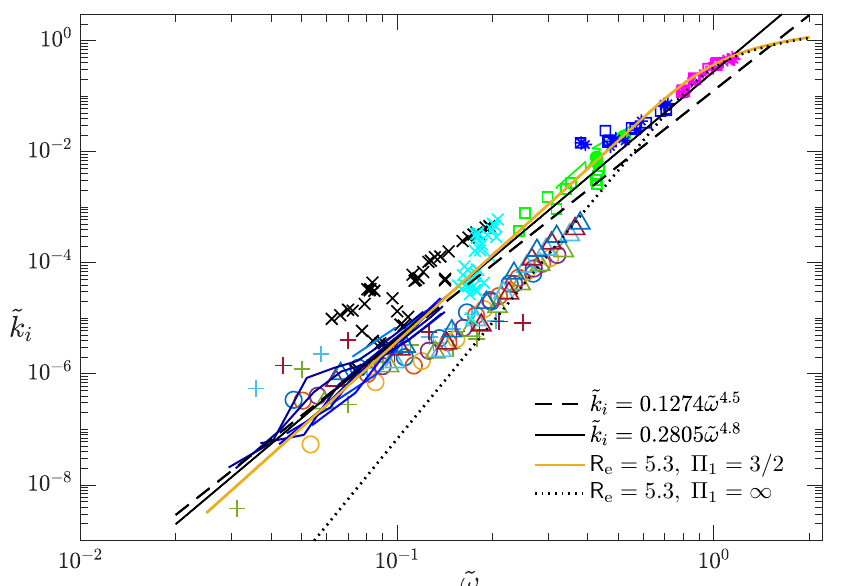
Figure 5. Comparison of modeled wave attenuation with data. The field data at lower ˜ ω : PIPERS dataset (bluish line segments joining the data points) with co-located satellite ice thickness (see [13,34] for details); Arctic ‘Sea State’ dataset (larger symbols +, , with various colors); two datasets for (cid:52) (cid:35) the Weddell Sea (larger symbols with color black and cyan). See [17] for h associated with the × ‘Sea State’ and Weddell Sea data. The smaller symbols at higher ˜ ω ( > 0.2) are the lab datasets with documented ice thickness: green, three tests in [29]; blue, two tests in [28]; magenta, two tests in